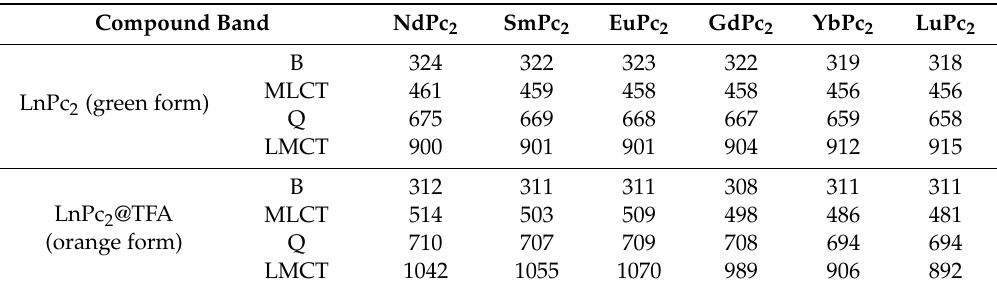
Table 1. Peak position ( λ max , nm) of the B, CT ( charge transfer ) and Q bands in the UV-Vis spectra of the initial (green) LnPc 2 complexes and the LnPc 2 @TFA conjugates (orange) in benzene; MLCT = metal-to-ligand charge transfer, LMCT = ligand-to-metal charge transfer.